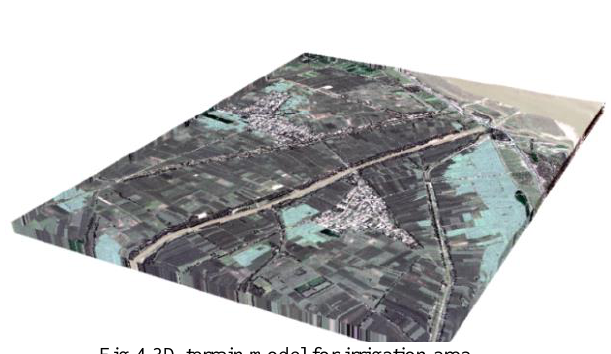
Fig.4 3D terrain model for irrigation area